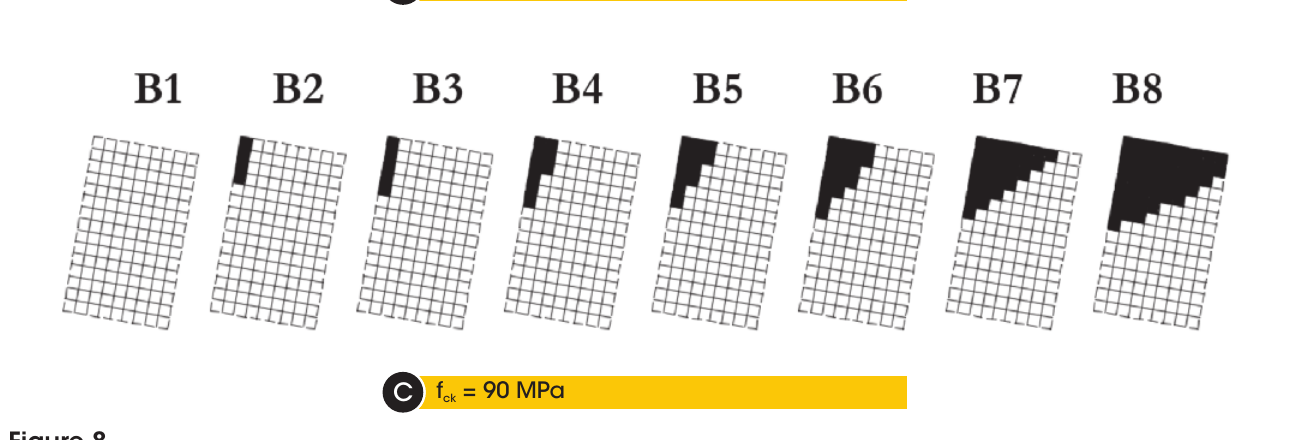
Figure 8 Perda de contato na almofada B Fonte: Autores